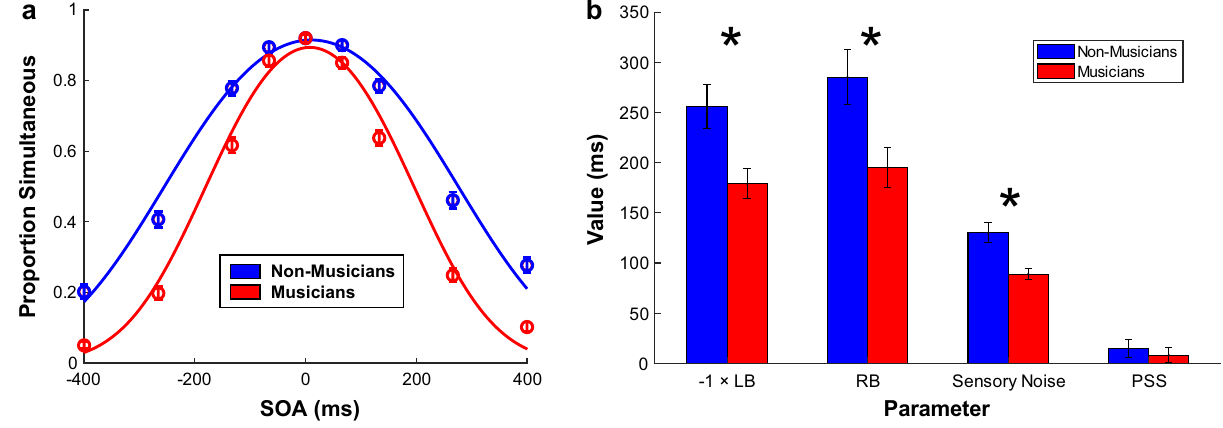
Figure 2. ( a ) The observer model fitted to simultaneity judgements for each group shows that musicians had a narrower temporal integration window (TIW) than non-musicians (i.e., musicians perceived synchrony between flashes and tones over a significantly narrower range of SOAs). Negative values indicate SOAs where the tone was presented first. ( b ) Musicians’ left boundary (LB; multiplied by − 1 in the figure) and right boundary (RB) were significantly closer to true simultaneity than non-musicians’, indicating they were stricter when integrating audiovisual cues. Musicians also had significantly reduced sensory noise, indicating greater sensory precision for audiovisual integration. The average of the boundaries (PSS) did not differ between the groups. Error bars show one standard error of the